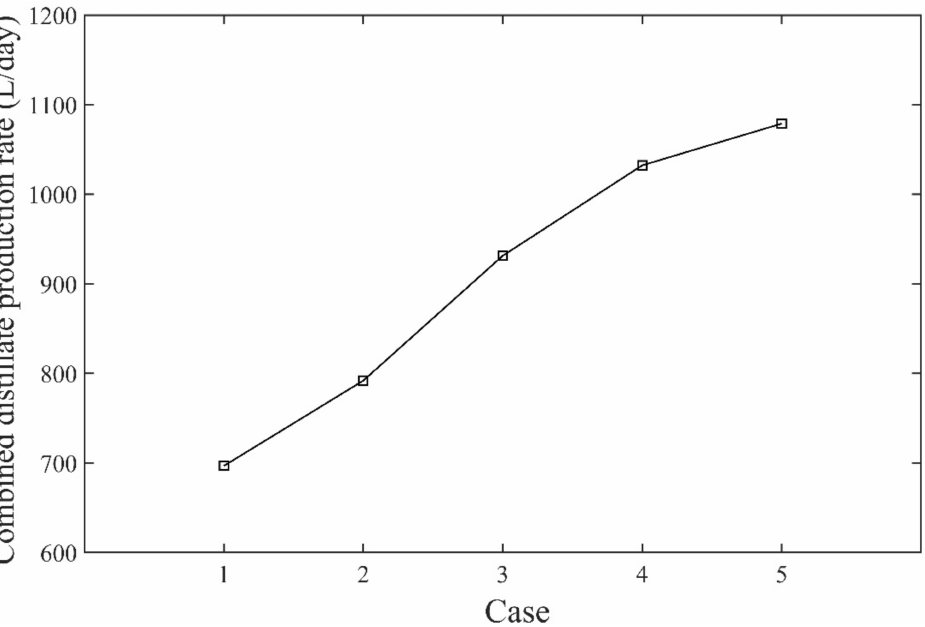
Figure 12. Combined distillate production rate of CDI–HDH system for all five cases.